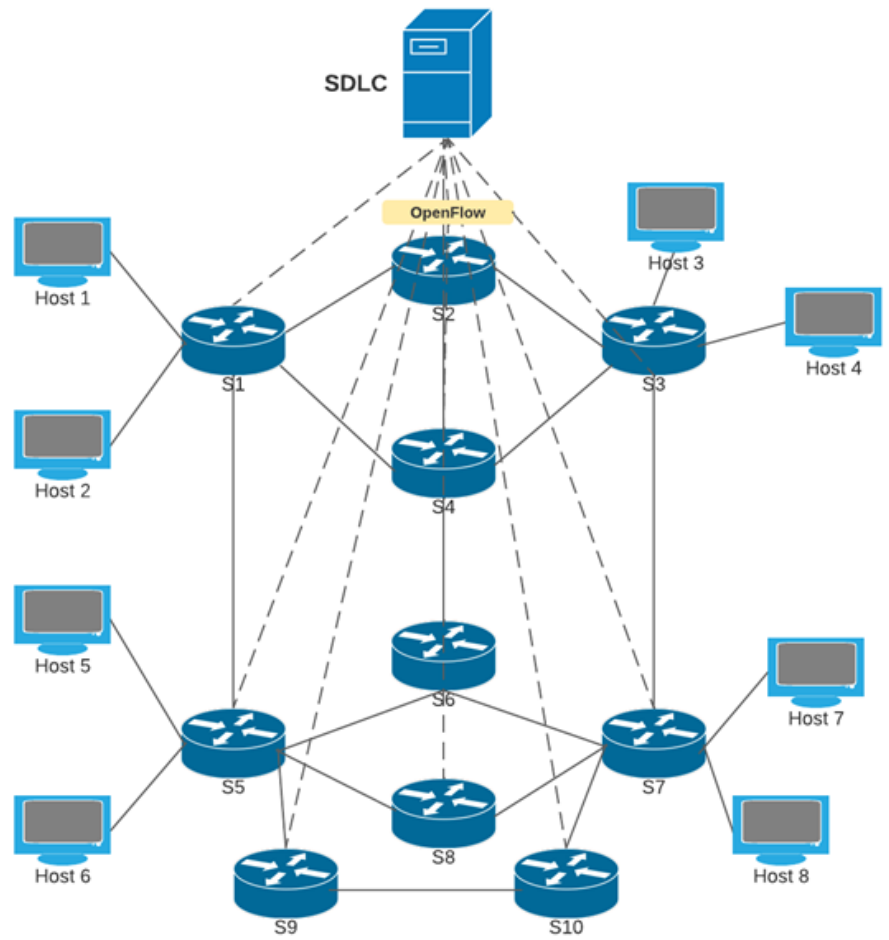
Figure 2. Mininet 10 switches emulation